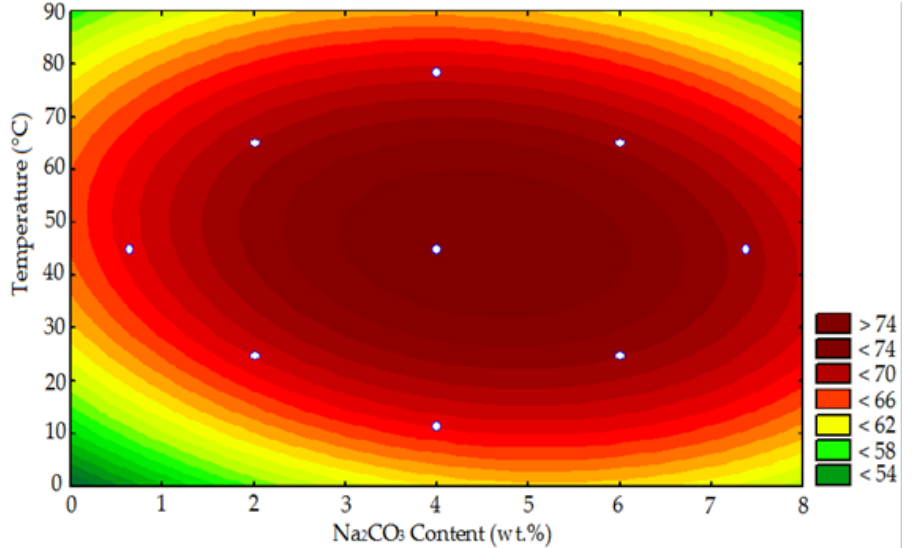
Figure 9. The contour plot dependency of activation temperature and Na 2 CO 3 concentration on CEC. Note: the white points in the image represent the lower and upper limits and the central point of the factors (temperature and Na 2 CO 3 concentration), including their critical points leading to a minimum and maximum CEC.